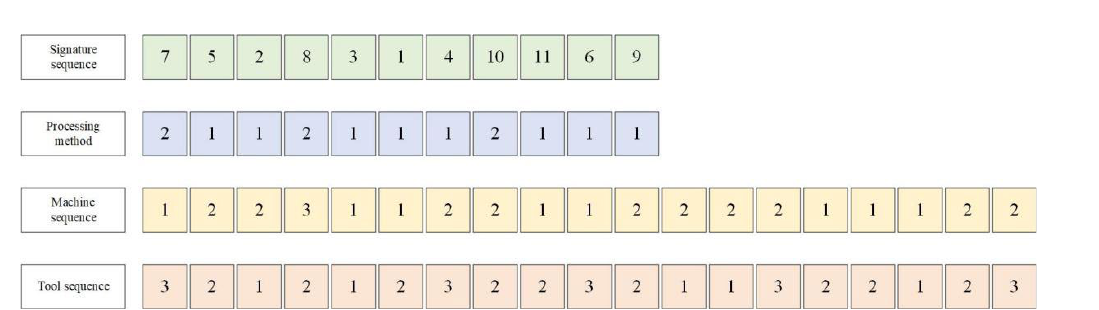
Figure 5. Tool layer encoding sequence.